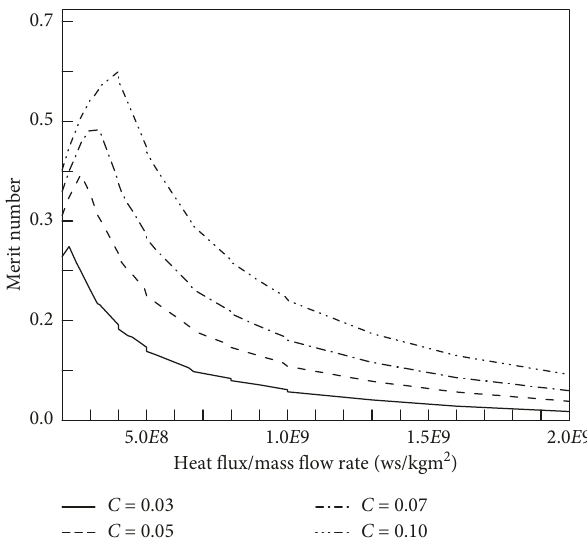
Figure 8: Effect of heat flux per unit mass flow rate on the Merit number for various concentrations of S44 slurry.